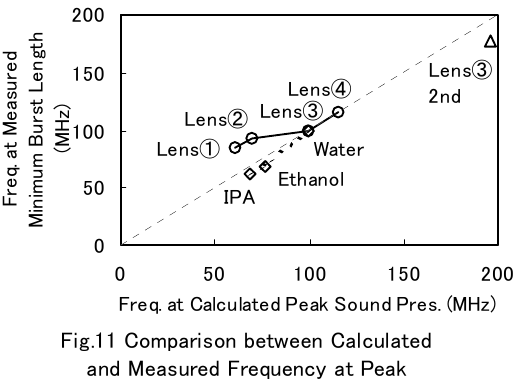
050100150200 q . e F r 0 200 Freq. at Calculated Peak Sound Pres. (MHz) Fig.11 Comparison between Calculated and Measured Frequency at Peak 0 Calculated Peak Sound Pres. Fig.12 Comparison between Calculated and Measured Peak 024681012 Calculated p N at Fig.13 Calculated Sound Pressure vs. Measured Energy Threshold